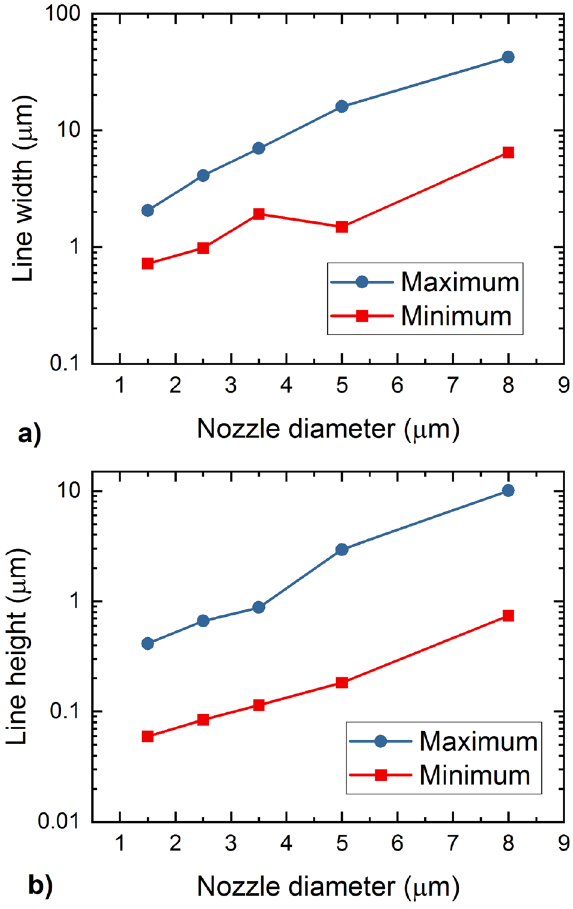
Figure 5. Line width ( a ) and height ( b ) with respect to the nozzle opening. The nozzle was tilted at 50 deg with respect to the substrate.